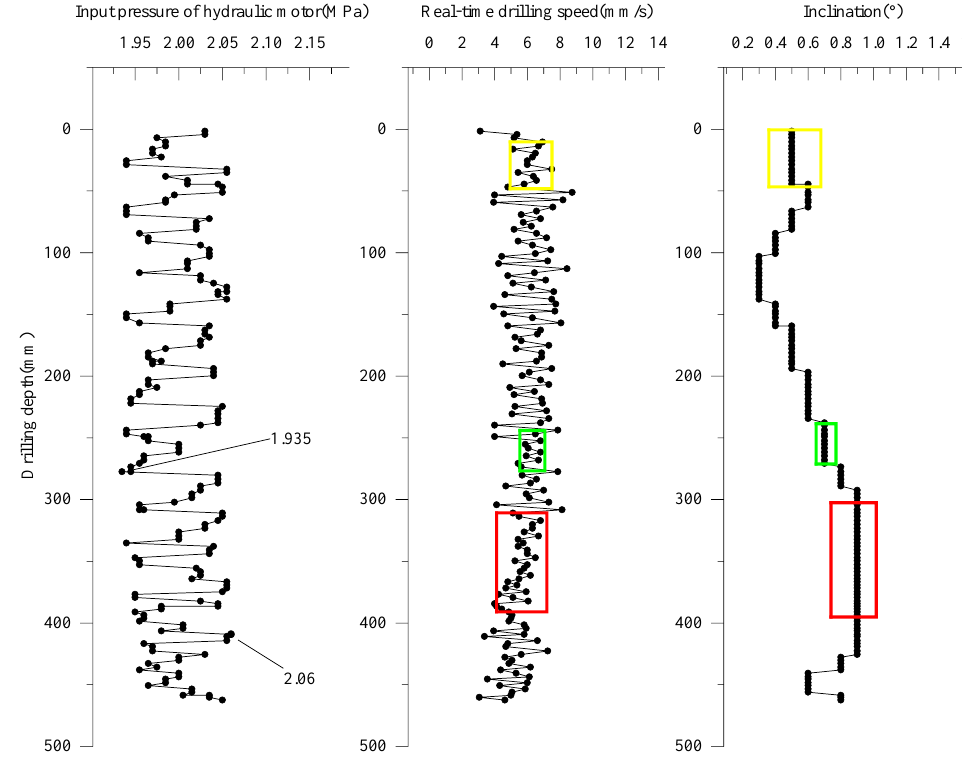
Figure 13. Change of drilling parameters during drilling process.